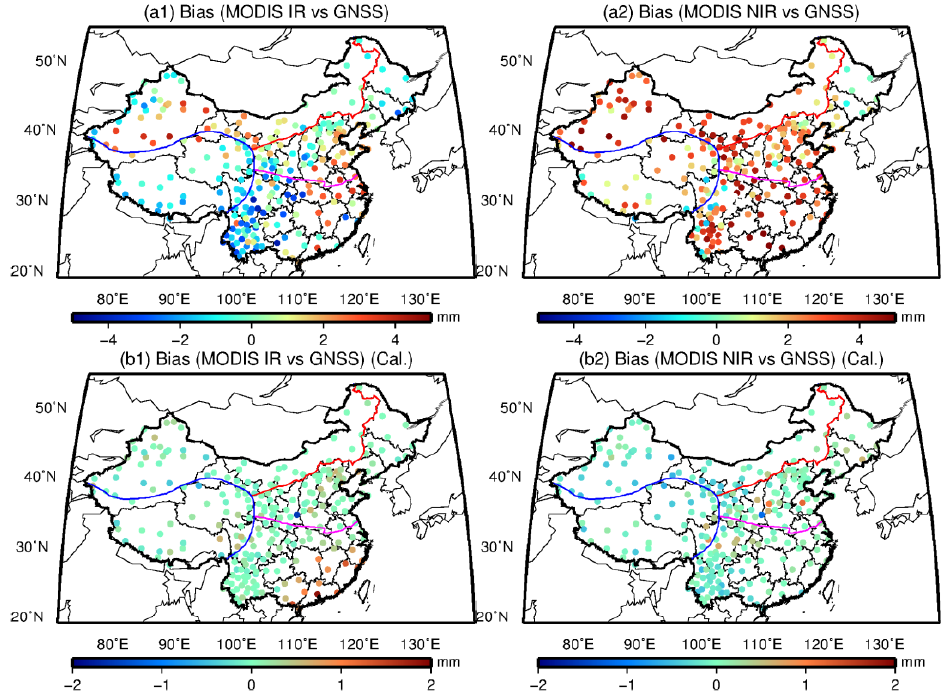
Figure 9. Bias distribution of paired stations between MODIS and GNSS over the period of 2011 – 2017, where the first row ( a1 , a2 ) represents the Bias of MODIS IR/NIR PWV without calibration and the second row ( b1 , b2 ) denotes the values with calibration using GNSS PWV.